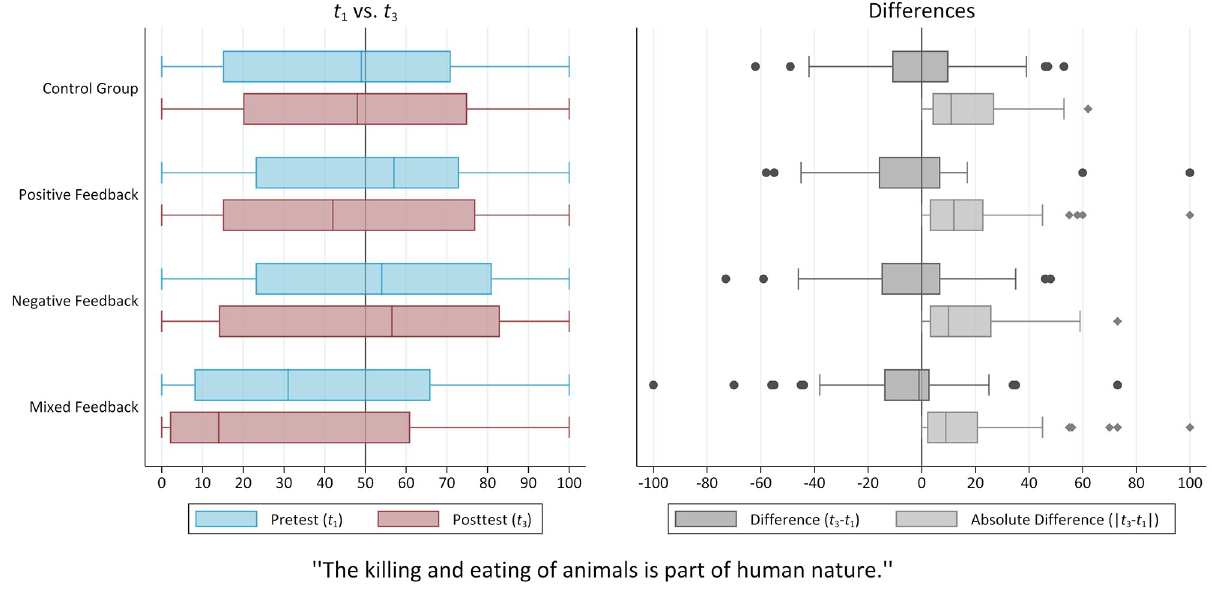
Fig 4. Boxplots of target item distributions and differences. S OURCE : ODSF2018 (https://doi.org/10.6084/m9.figshare.16595378.v1), own calculations.